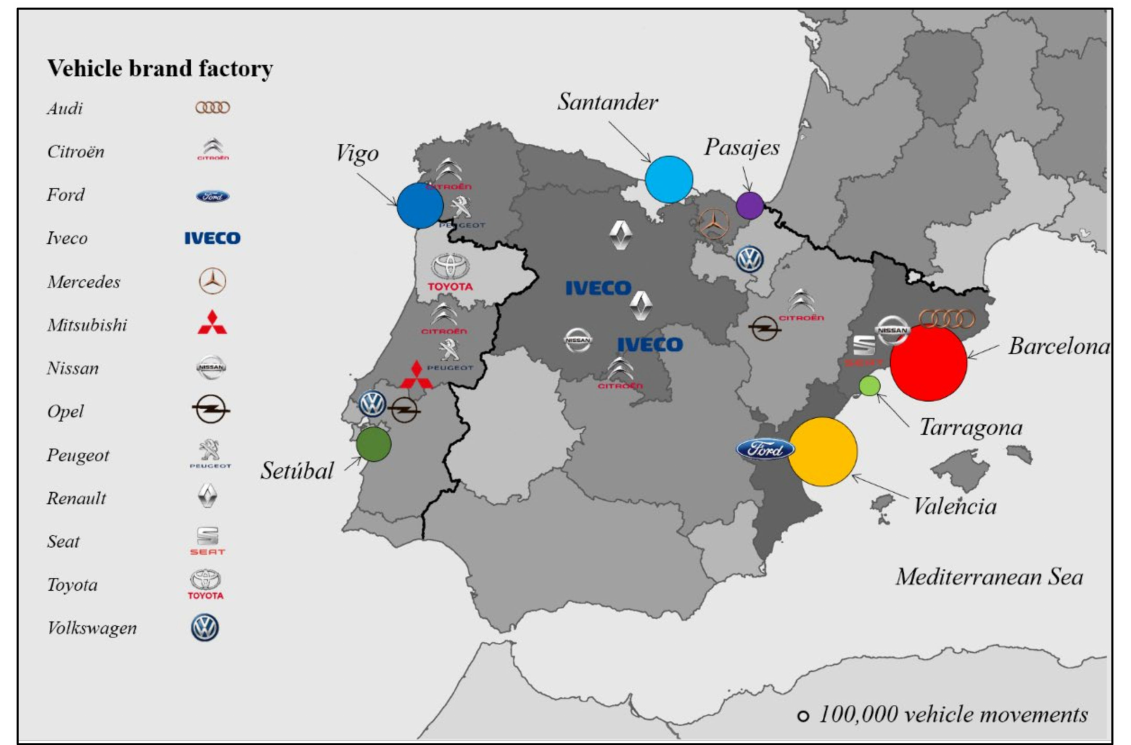
Figure 3. Map of the locations of vehicle factories and ports with PCC/PCTC ship traffic on the Iberian